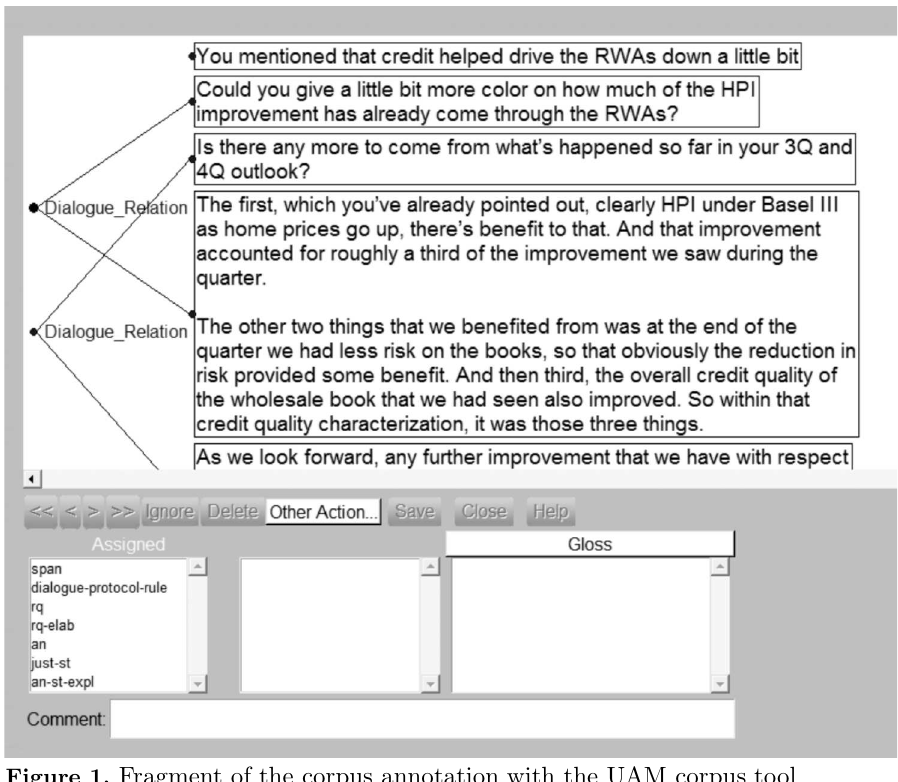
Figure 1. Fragment of the corpus annotation with the UAM corpus